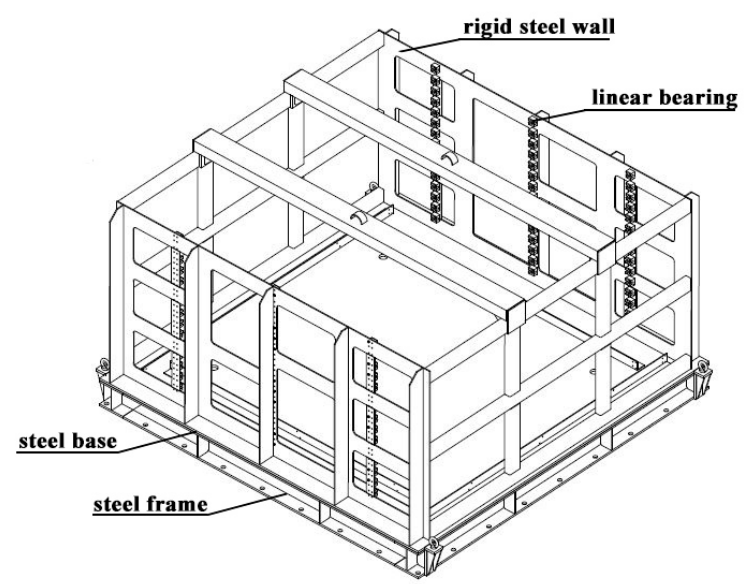
Figure 19. Isometric view of the rigid steel walls.